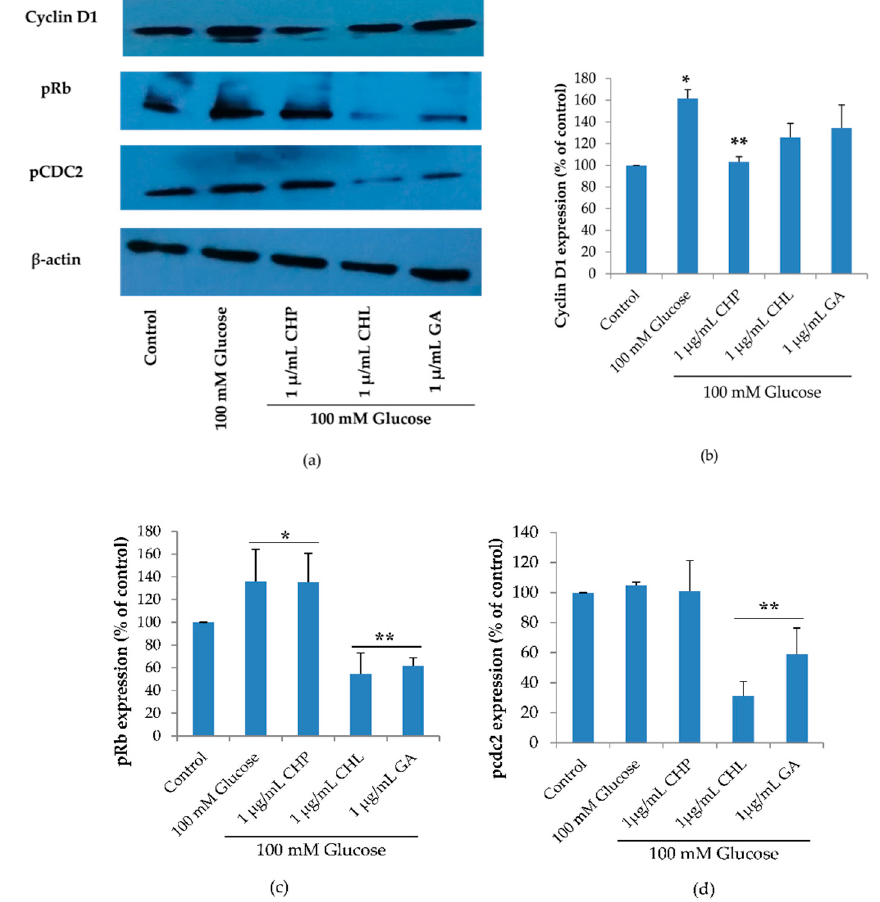
Figure 8. Cyclin D1, phospho-Retinoblastoma (pRb) and phospho-cell division cycle 2 (pcdc2) expression, as shown in a representative Western blot ( a ) . Normalized values of Cyclin D, pRb and pcdc2 against β -actin (( b ) , ( c ) and ( d ) , respectively). The mean ± SD values of normalized Cyclin D, pRb and pcdc2 expression were obtained from three independent experiments, * p < 0.05 vs. control; ** p < 0.05 vs. 100 mM glucose alone. For Cyclin D1, p values were 0.019 and 0.027 for 100mM glucose and CHP, respectively. For pRb, p values were 0.037, 0.049, 0.001 and 0.002 for 100 mM glucose, CHP, CHL and GA, respectively. For pcdc2, p values were 0.011 and 0.042 for CHL and GA, respectively.